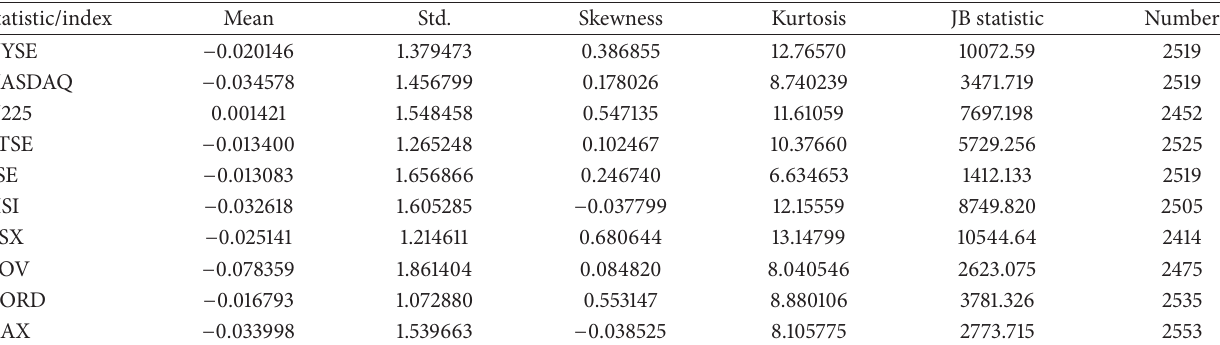
Table 1: Descriptive statistics of returns.